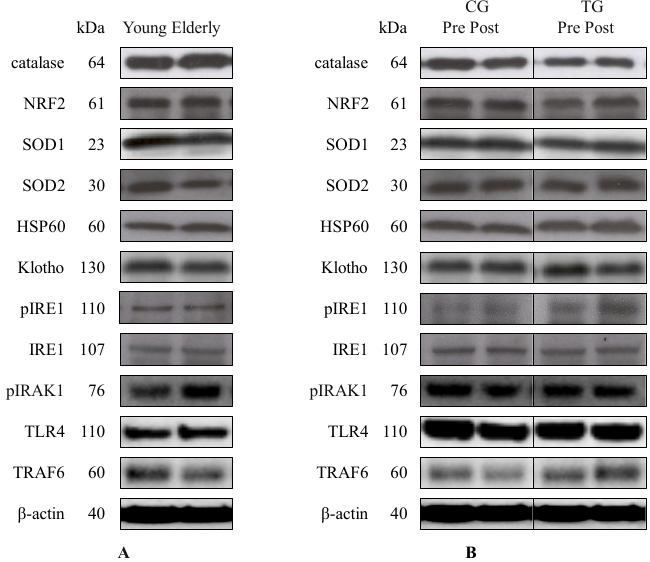
A B Figure 1. Representative Western blots showing the effects of aging (young, n = 11 (M); elderly, n = 30 (18/12 F/M)) ( A ) and resistance training (CG, n = 8 (7/1 F/M); TG, n = 22 (11/11 F/M)) ( B ) on catalase, NRF2, SOD1, SOD2, HSP60, Klotho, pIRE1, IRE1, pIRAK1, TLR4, and TRAF6 protein expression in PBMCs. CG, control group; F, female; M, male; TG, training group. Additionally, both the CG and TG did not demonstrate any differences in the basal protein content of catalase, GSH, HSP60, Klotho, LP, pIRAK1, pIRE1/IRE1 ratio, ROS, SOD1, SOD2, and TLR4. However, a significant difference was found in the NRF2, PC, and TRAF6 protein expression between both groups (Table 4/Figure 1b). Table 4. Oxidative status, UPR IRE1 pathway activation, and inflammatory response in the elderly at baseline and after an 8-week resistance training.